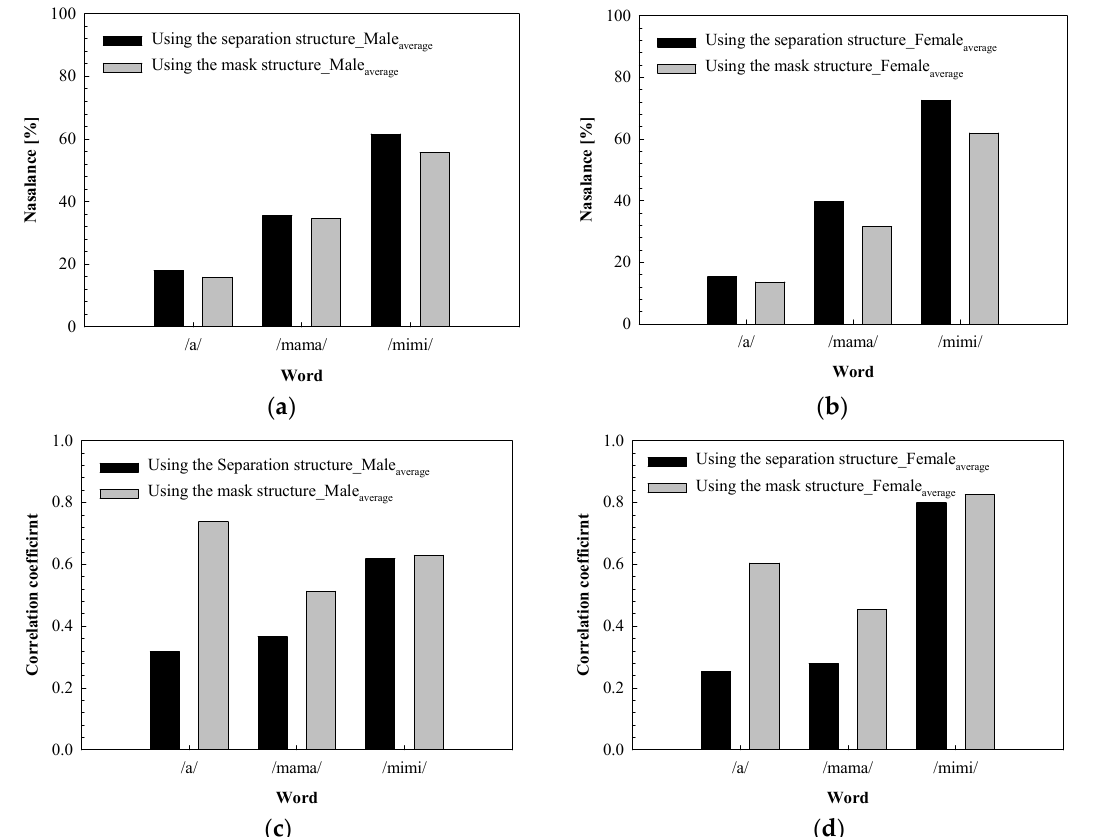
Figure 10. Calculated nasalance results comparison for ( a ) males and ( b ) females, and correlation